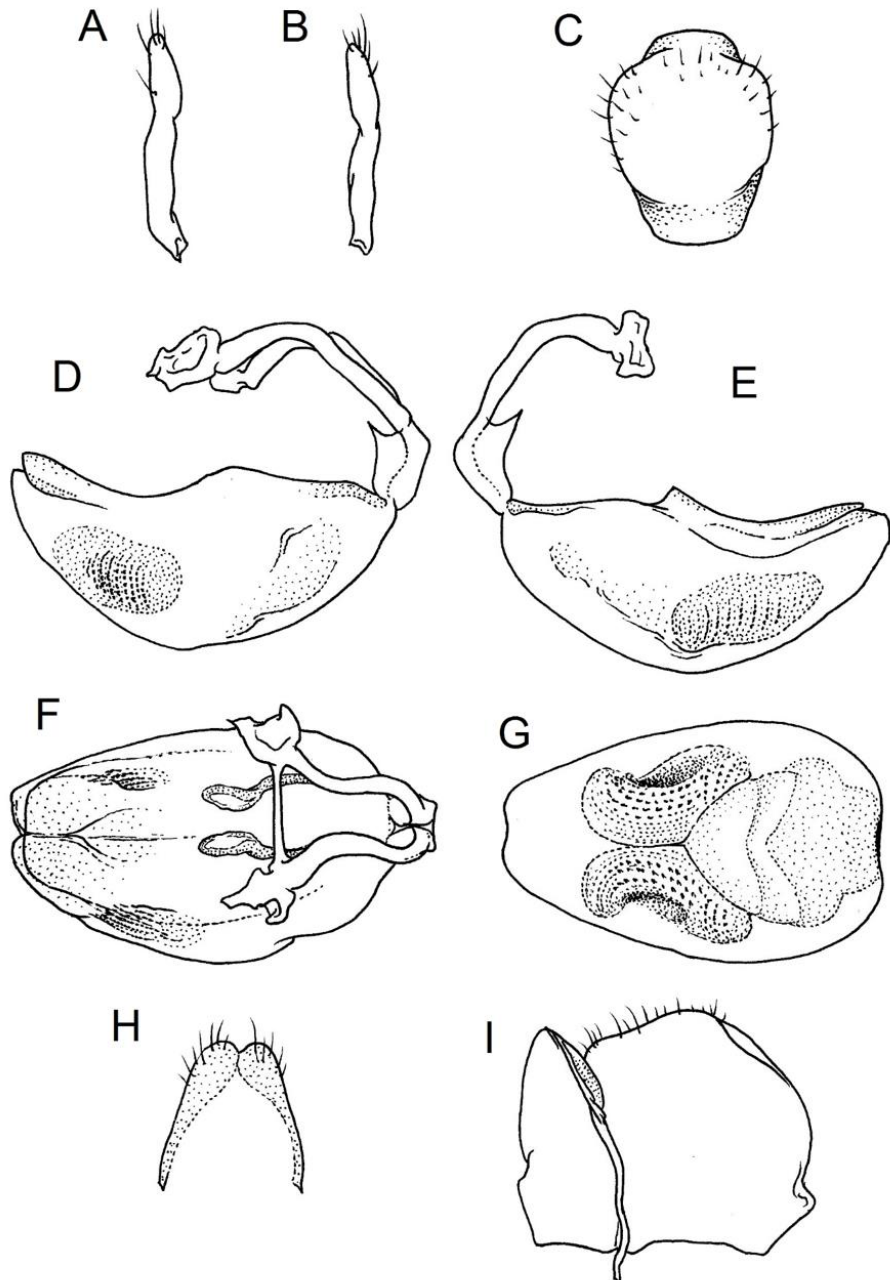
Figure 49. Phonoctonus lutescens (Guérin-Méneville & Percheron, 1834): ( A ) left paramere; ( B ) right paramere; ( C ) pygophore, ventral view; ( D ) aedeagus, right lateral view; ( E ) aedeagus, left lateral view; ( F ) aedeagus, dorsal view; ( G ) aedeagus, ventral view; ( H ) styloids, outer view; and ( I ) gonocoxite of abdominal segment VIII. Redescription Colour : Body generally pale — red and light greyish with black patterns on prono- tum, thorax, and hemelytra (Figure 30B). Head : Red. Scapus and basal portion of pedicellus are red. Apical portion of pedicel- lus, basiflagellomerus, and distiflagellomerus is black. Thorax : Collar of anterior pronotal lobe is yellowish with red ovoid depressions (Fig- ures 6I and 8I). Anterior pronotal lobe is red with brown anterior margin (brown tripe